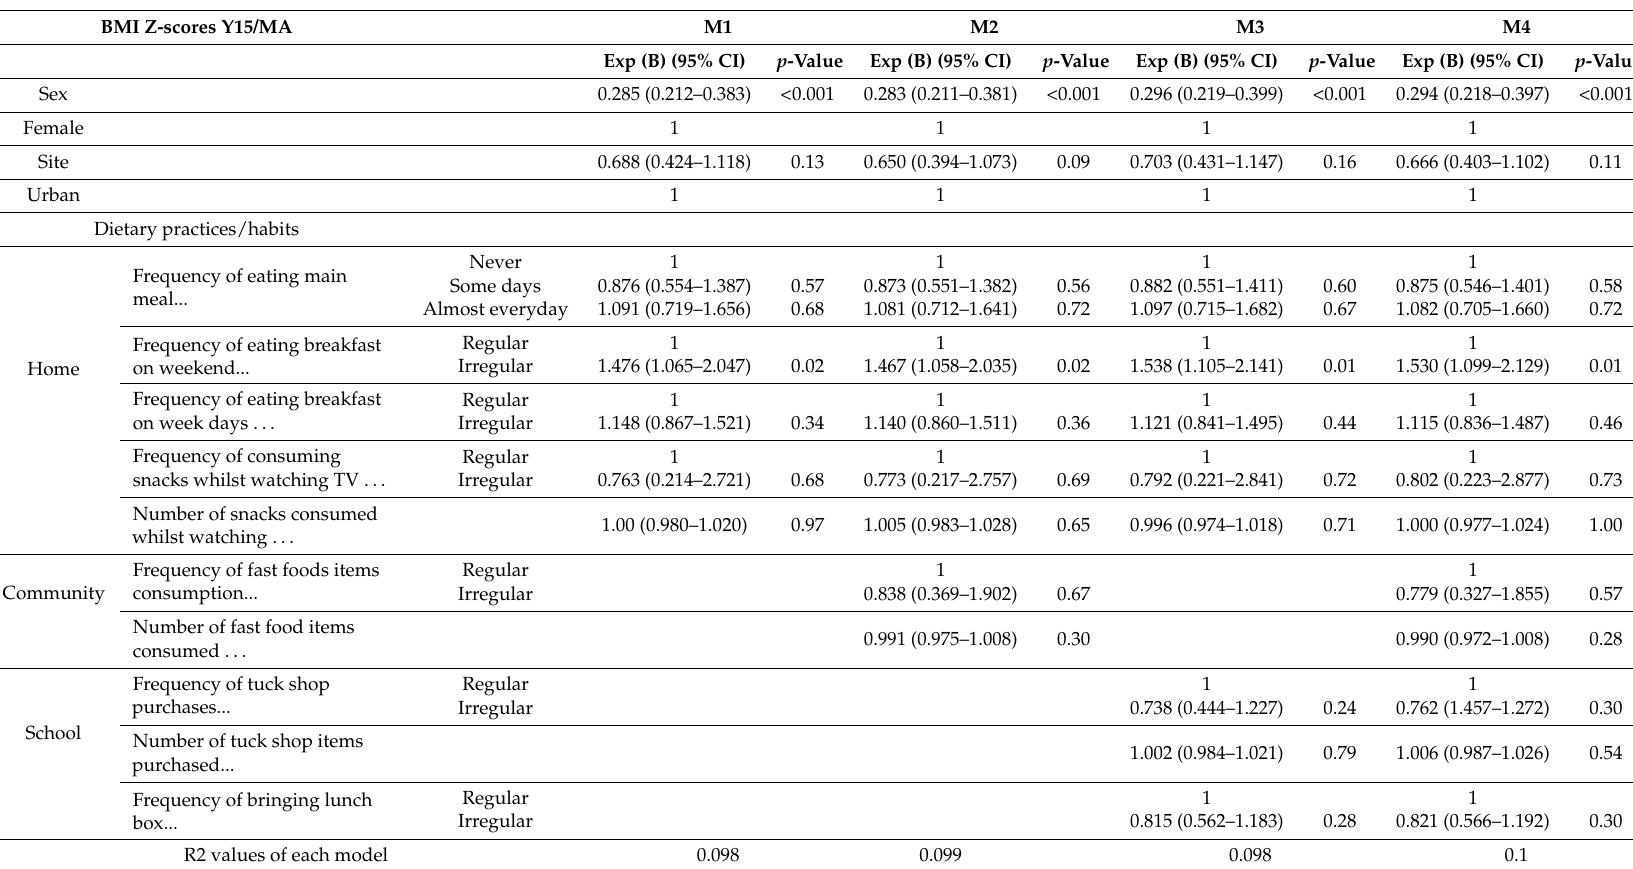
Table 6. Multiple logistic regression analysis for risk of being overweight or obese (BMI for age Z-score cut-offs), gender, site and dietary practices in different settings among Y15/MA